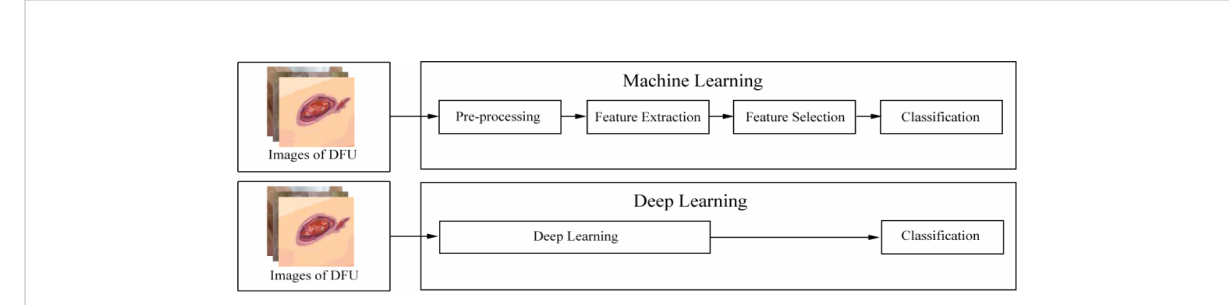
FIGURE 1 The difference between conventional machine learning and deep learning. After images of diabetes-related foot ulcer (DFU) are inputted into a machine-learning model, these images are processed following this pipeline: pre-processing, feature extraction, or feature selection. Then, these images are fi nally classi fi ed. However, after images of DFU are inputted into a deep-learning model, the model automatically learns representations of these images. Then, these images are fi nally classi fi ed. According to the Wagner – Meggitt (15) wound classi fi cation for foot- ulcer evaluation, the images of DFU was are considered grade 1 (super fi cial